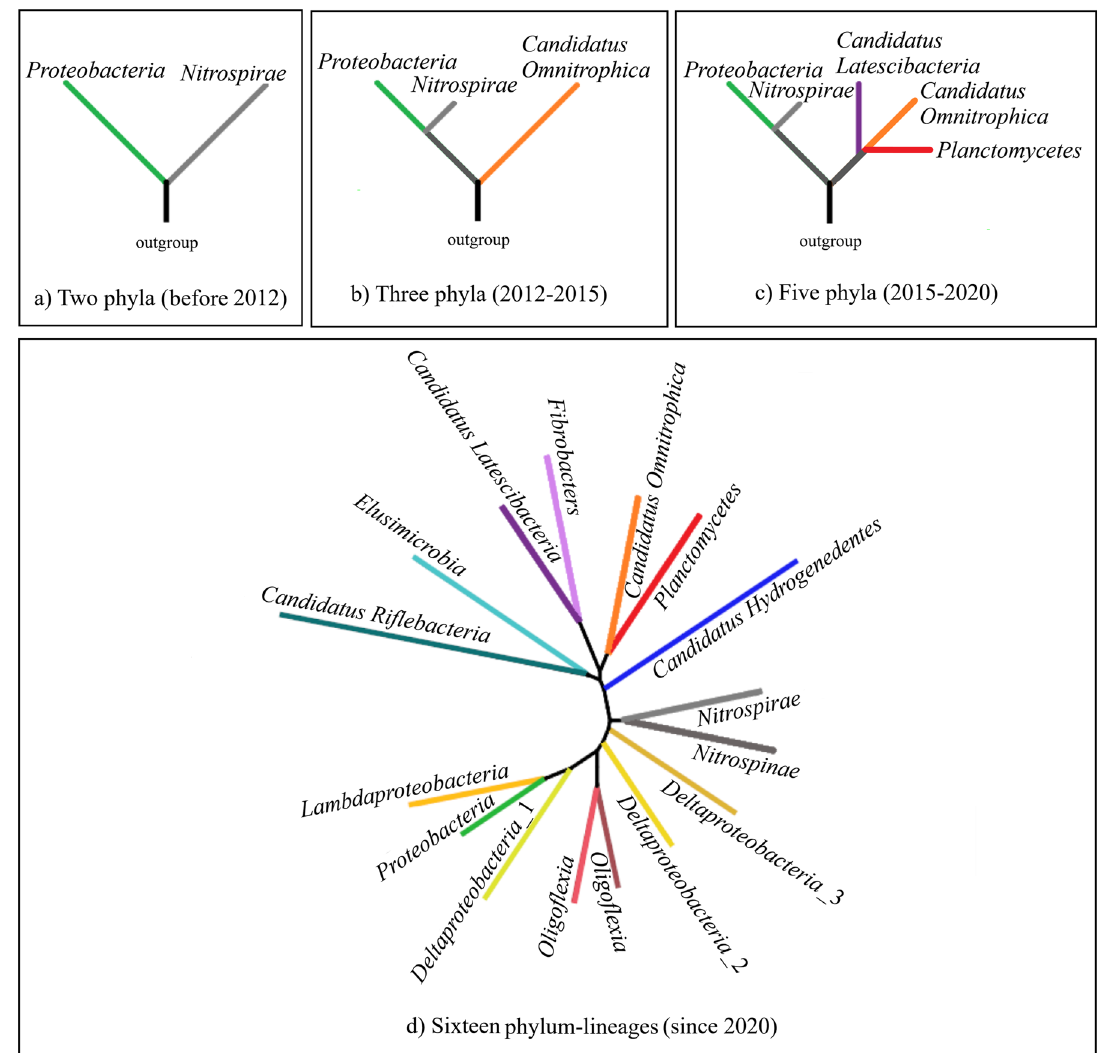
Fig. 2 Schematic representation of the gradual expansion of the phylogenetic tree of MTB in the Bacteria domain. a Before 2012, only two phyla ( Proteobacteria and Nitrospirae ) were identi fi ed to contain MTB. b Between 2012 and 2015, an additional branch for the Candidatus Omnitrophica phylum was added 28 . c Subsequently, two bacterial phyla ( Candidatus Latescibacteria 29 and Planctomycetes 21 ) were added to the MTB tree of life based on the presence of magnetosome gene clusters in their genomes. d The latest addition to the MTB tree has expanded its branches to a total of sixteen bacterial phylum-level lineages 30,31 . All taxonomic groupings are based on the NCBI taxonomy